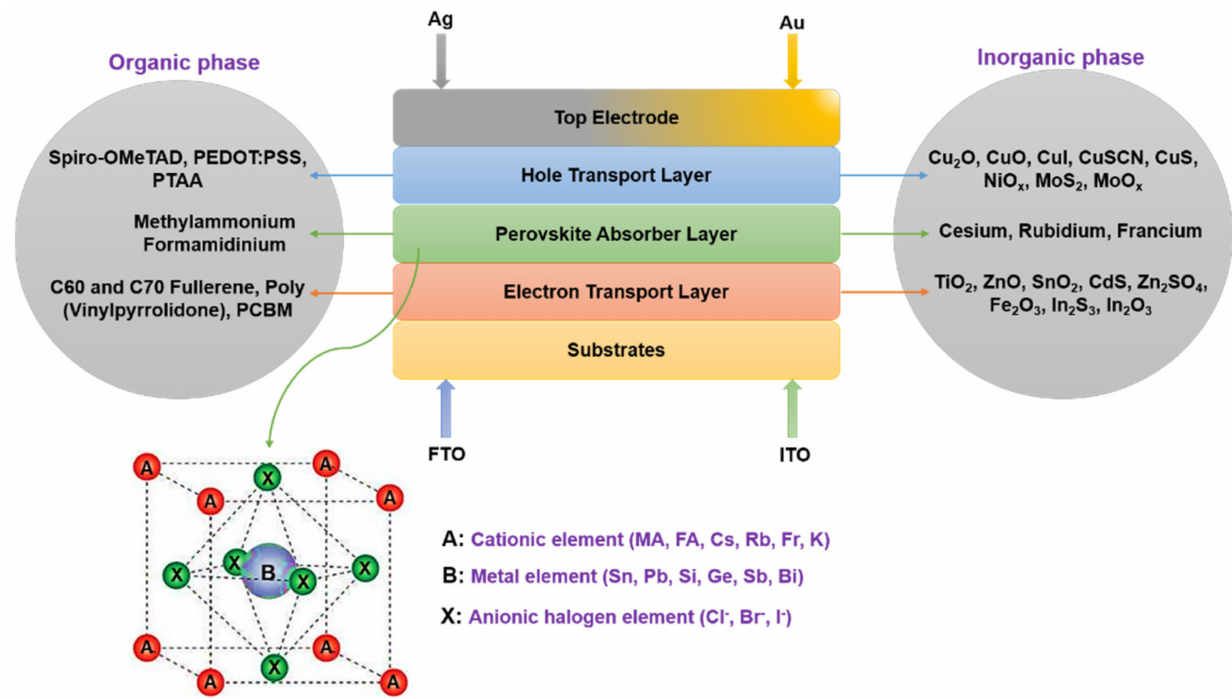
Figure 1. The multi-element structure of a perovskite solar